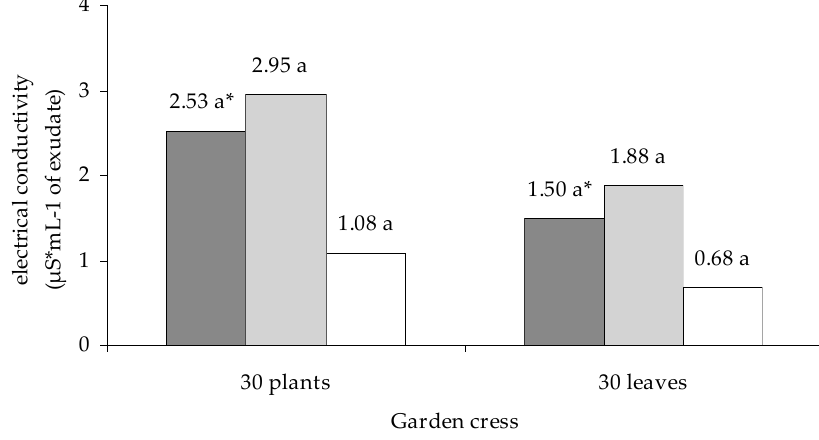
Figure 3. Effect of the culture filtrates from 18 strains of E. nigrum on electrical conductivity of exudates from garden cress ( L. sativum L.) after 7 days of incubation. Means followed by the same letter (*) are not statistically different at the α ≤ 0.01 level according to the Tukey HSD test.